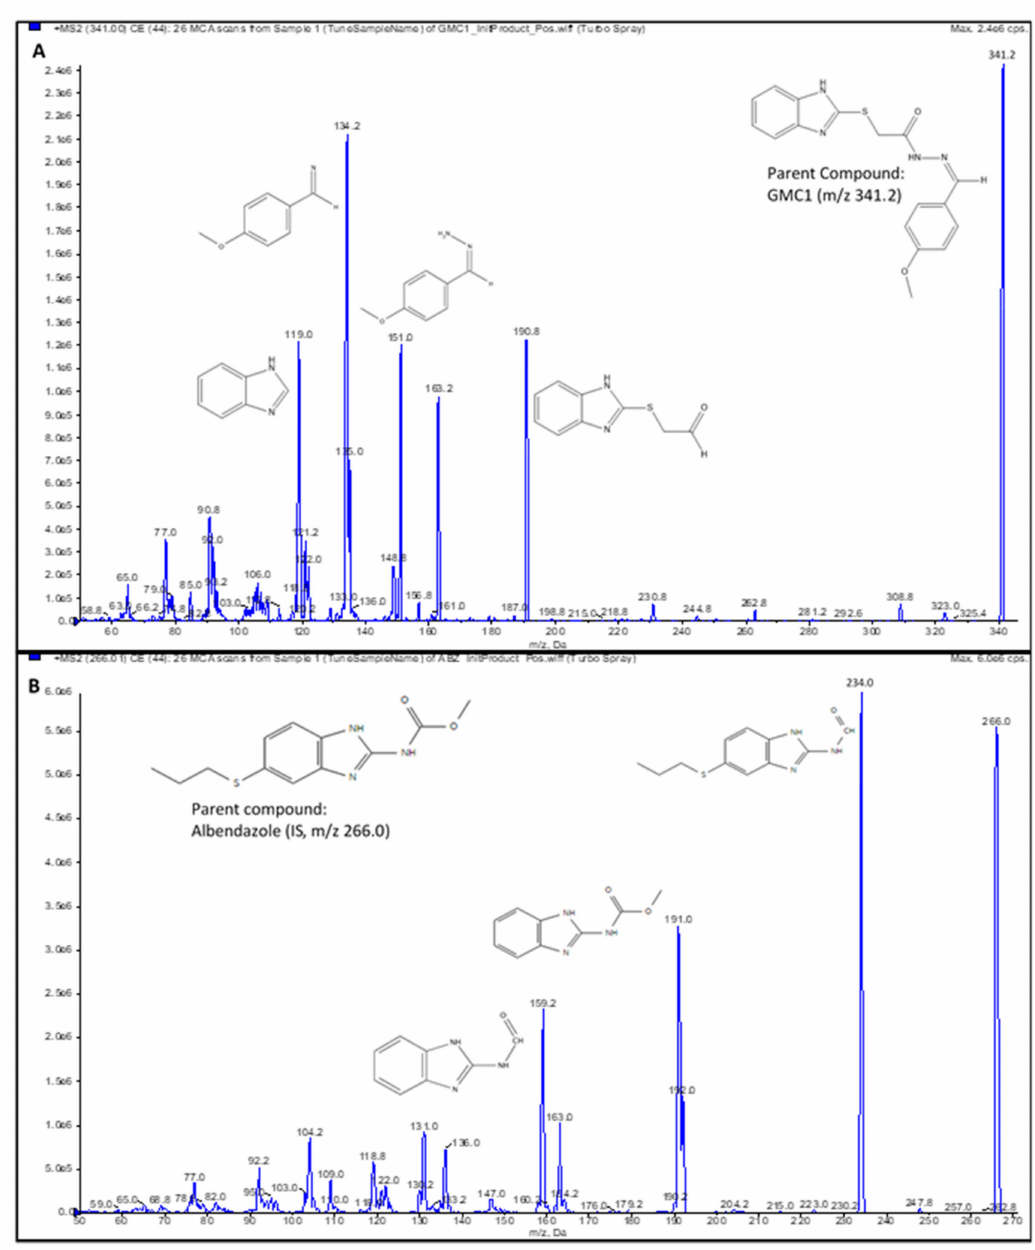
Figure 4. Product ion spectra. ( A ) GMC1 precursor ion ( m / z 341.2) and product ions ( m / z 190.8, 151.0 and 134.2); ( B ) Albendazole (IS) precursor ion ( m / z 266.0) and product ions ( m / z 234.0, 191.0 and